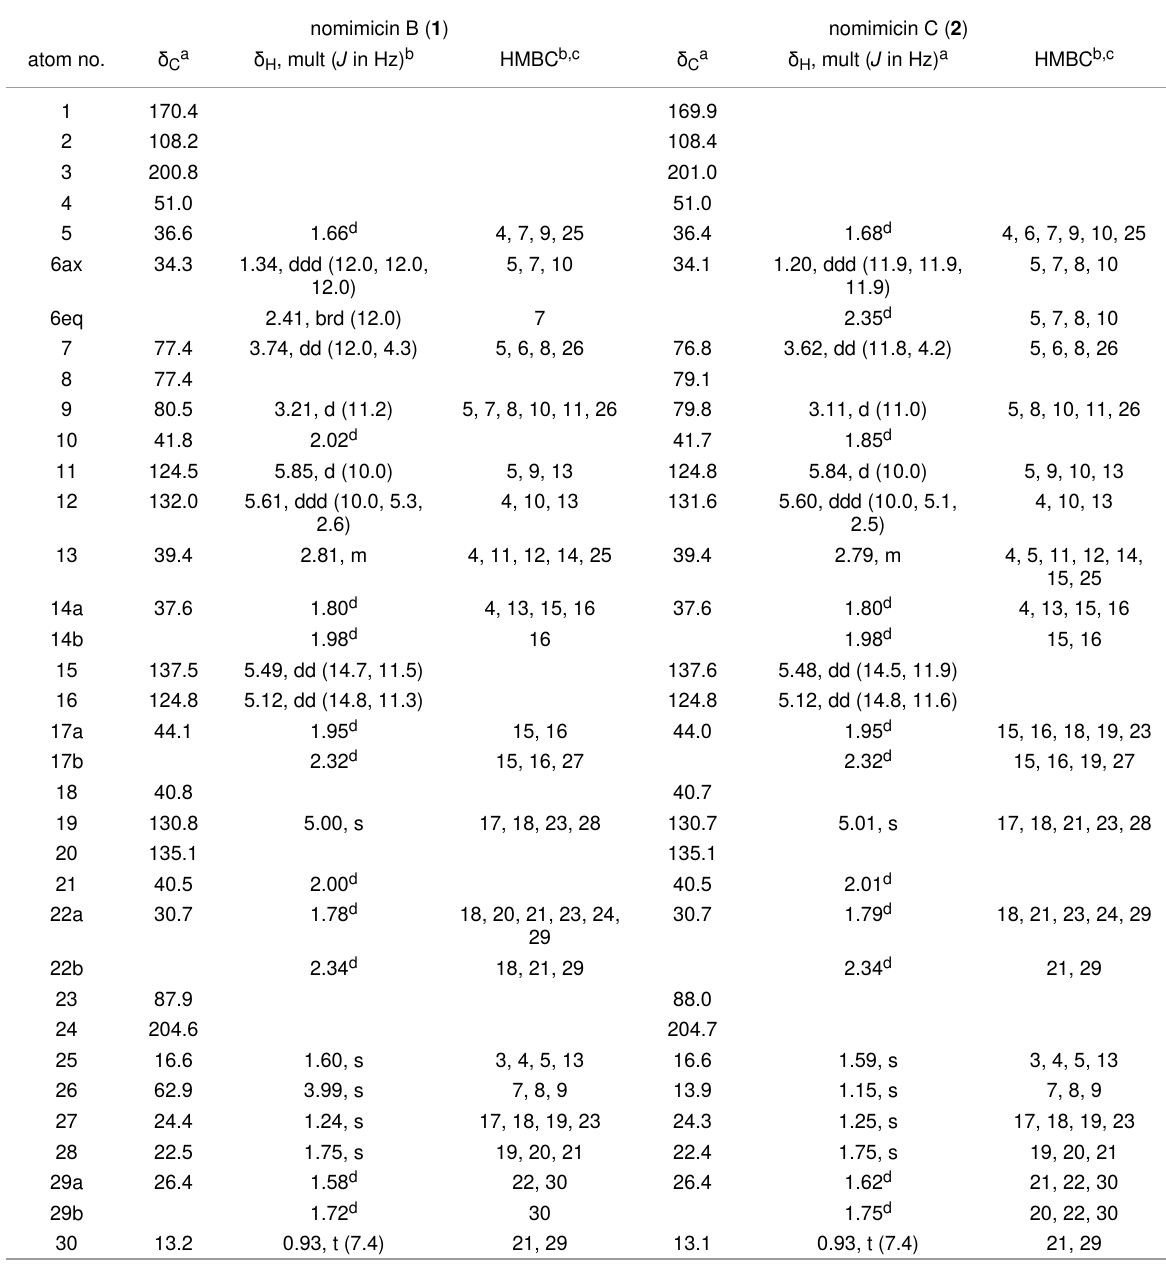
Table 1: 1 H and 13 C NMR data for nomimicins B ( 1 ) and C ( 2